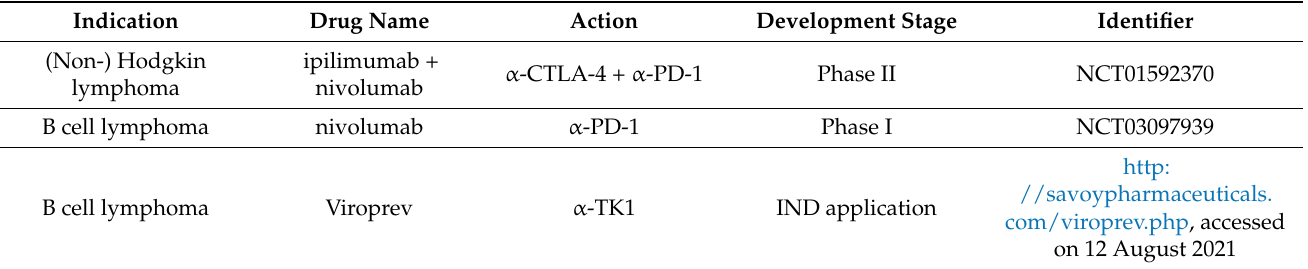
Table 4. Antibody pipeline for EBV-linked